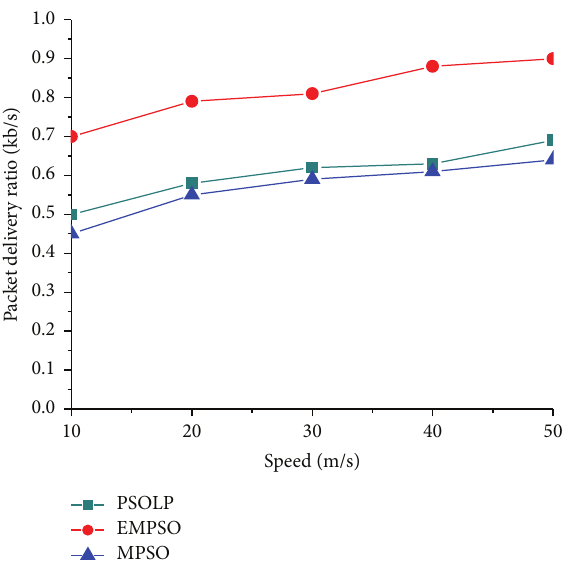
Figure 5: Delay versus speed.